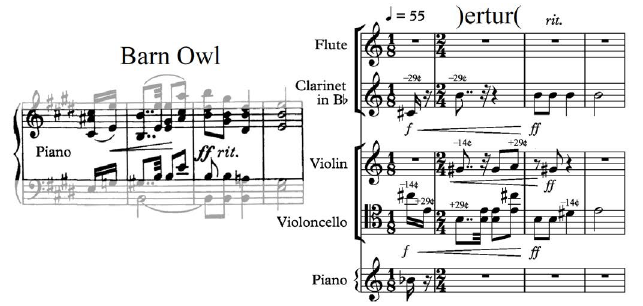
Figure 24: Janáček’s Barn Owl treated for ) ertur